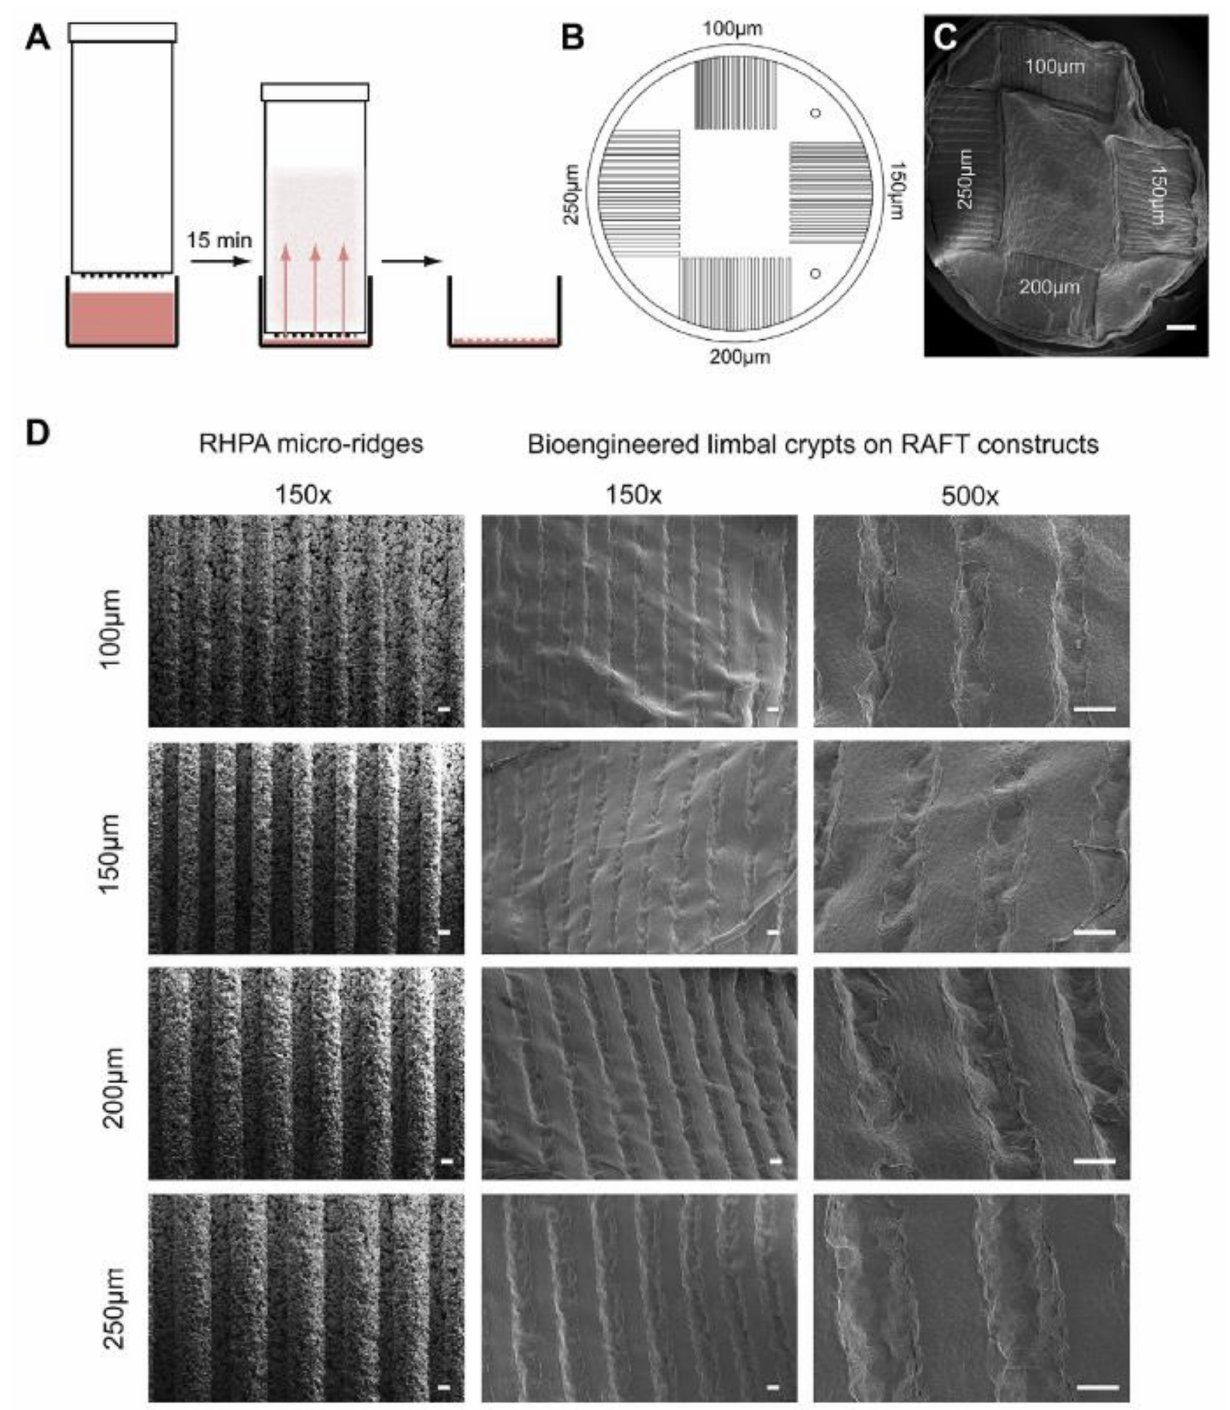
Figure 6. Production of BLC-containing RAFT constructs using RHPAs. ( A ) Shows a schematic of the RAFT process using RHPAs which are placed on top of a collagen hydrogel in a 24-well plate and incubated for 15 min. This will allow wicking of liquid from the hydrogel. RHPAs are then removed, and the RAFT construct remains at the bottom of the well. ( B ) Shows a schematic pattern of topography of micro-ridges on the base of RHPAs whiles. ( C ) Shows SEM images of a RAFT construct showing four different topologies on the same surface. ( D ) Shows the SEM images of the protruding micro-ridges of variable depth on the RHPA surface and corresponding BLCs produced in the surface of the RAFT constructs. Scale bars, C: 1 mm, D: 100 µ m